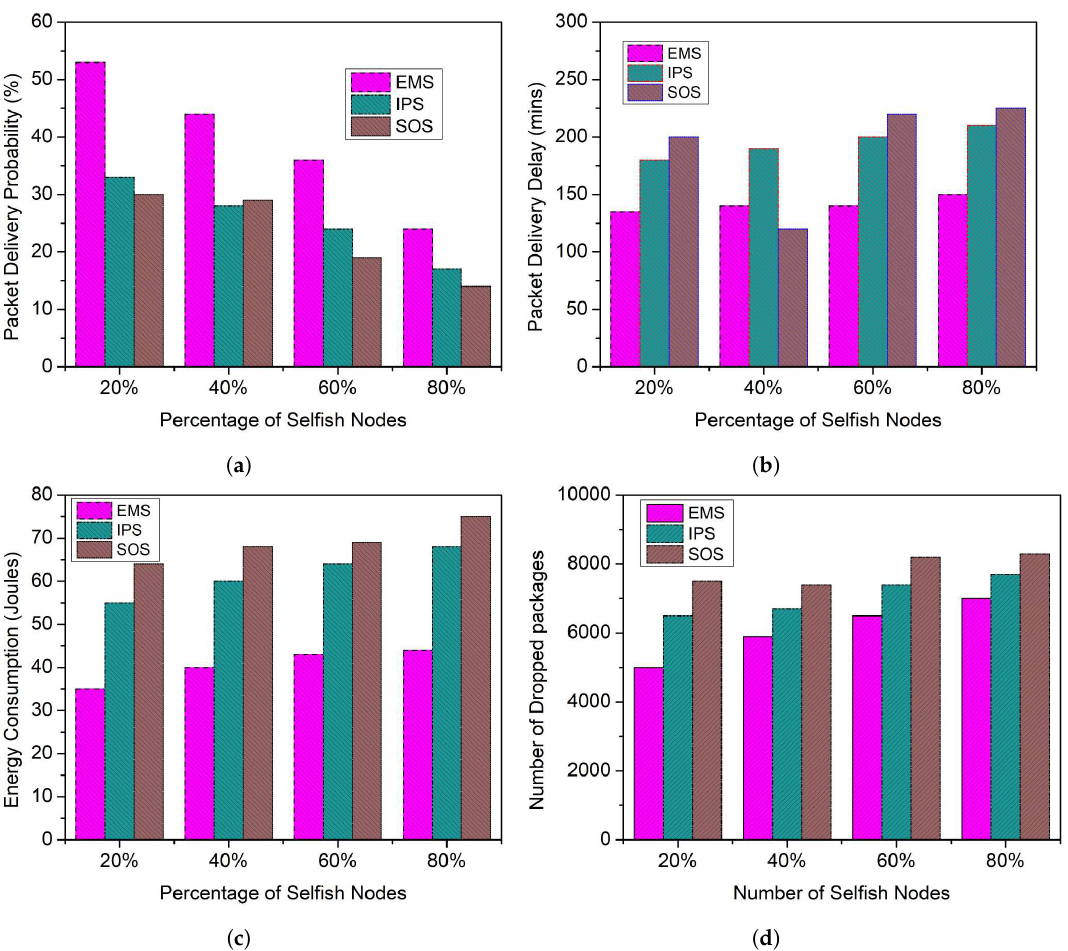
Figure 6. Comparison of EMS, IPS, and SOS schemes for Selfish Nodes of 20% to 80%. ( a ) Packet Delivery Probability; ( b ) Packet Delivery Delay; ( c ) Energy Consumption; ( d ) Number of Dropped